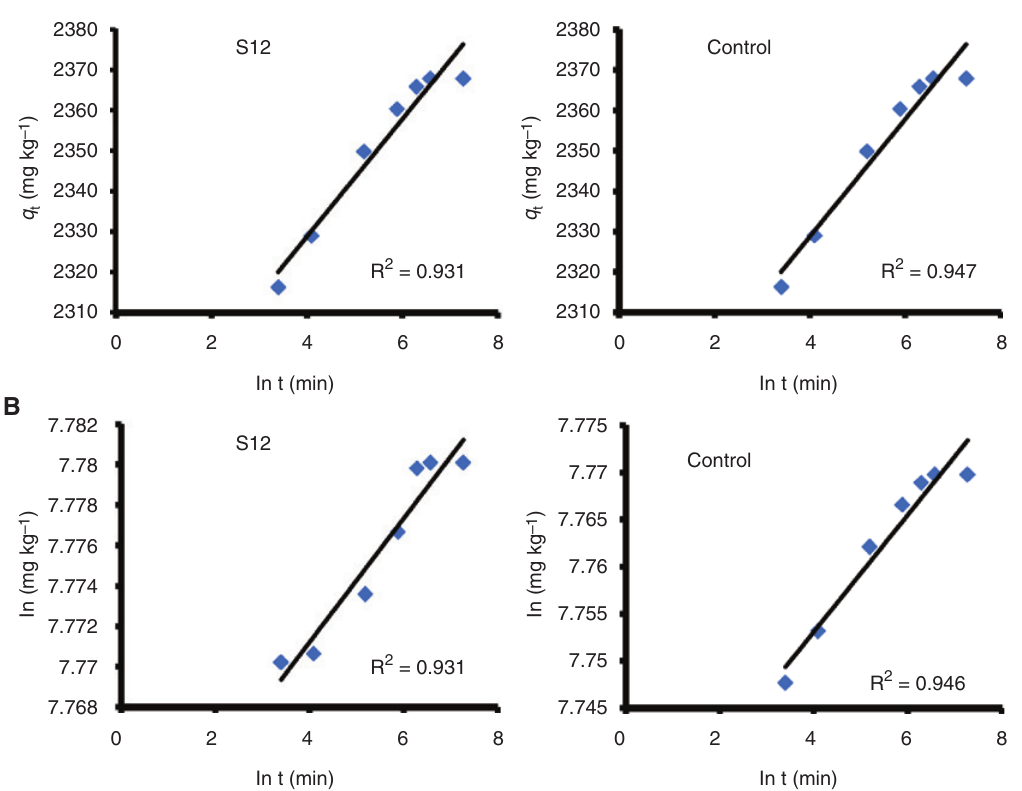
Figure 4: Cd sorption kinetic data for treated soil (S12) and control soil (A) fit of the simple Elovich equation (B) fit of the Power function